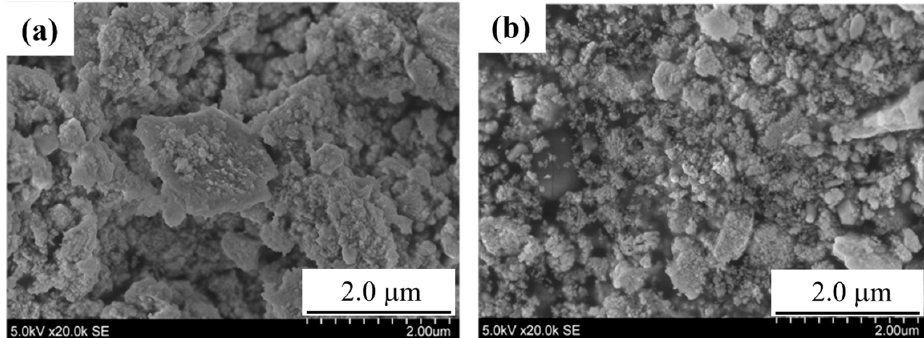
Figure 5. FE-SEM images of the powders of samples A ( a ) and B ( b ).